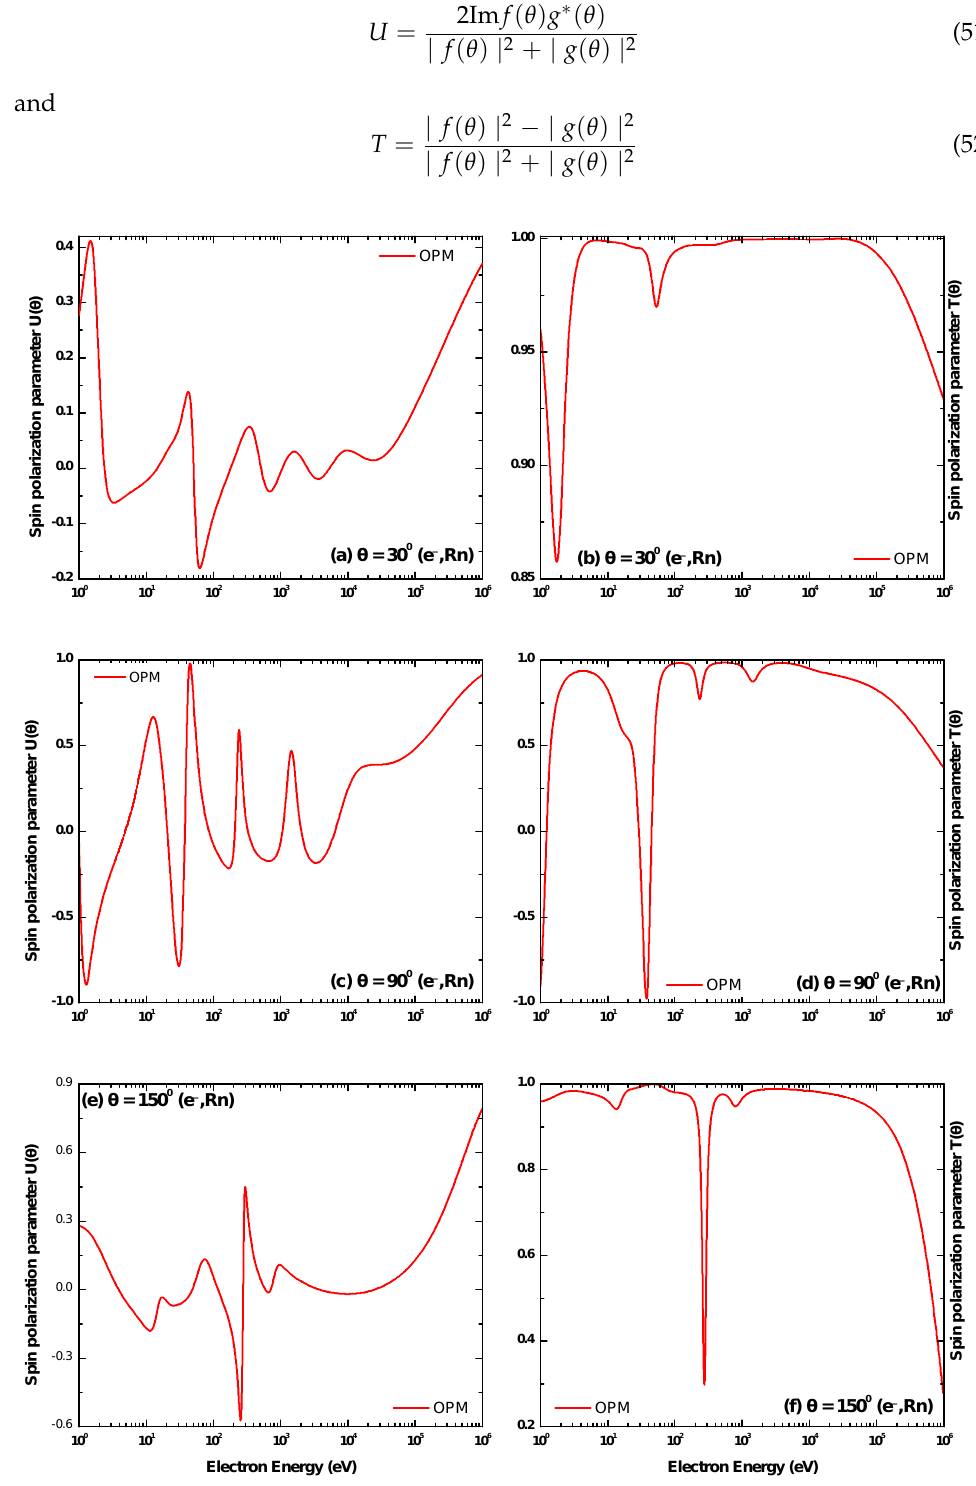
Figure 14. Energy dependence of the spin polarization parameters U and T for elastic scattering of electrons from neutral radon atoms at scattering angles ( a , b ): 30 ◦ , ( c , d ): 90 ◦ and ( e , f ): 150 ◦